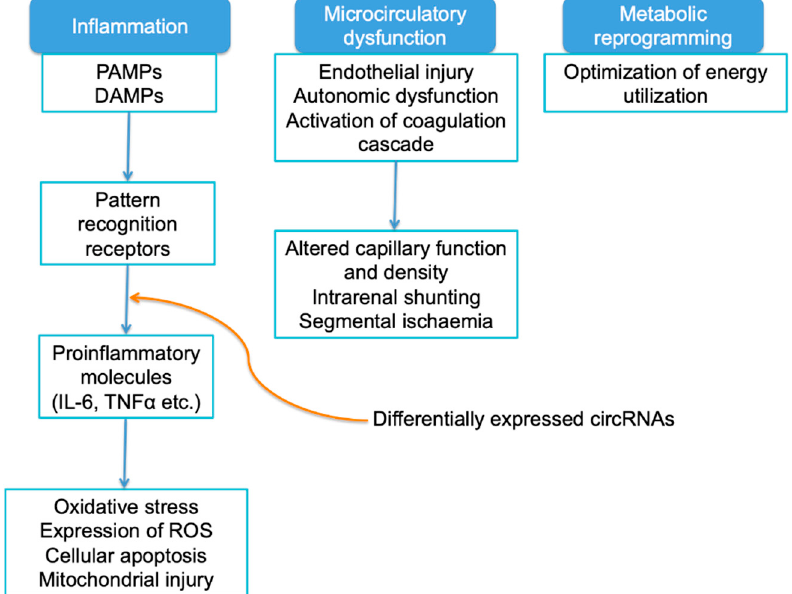
Figure 2. A schematic diagram of the pathophysiology of septic acute kidney injury (AKI). DAMP: damage-associated molecular patterns; PAMP: pathogen-associated molecular pattern; ROS: reactive oxygen species.